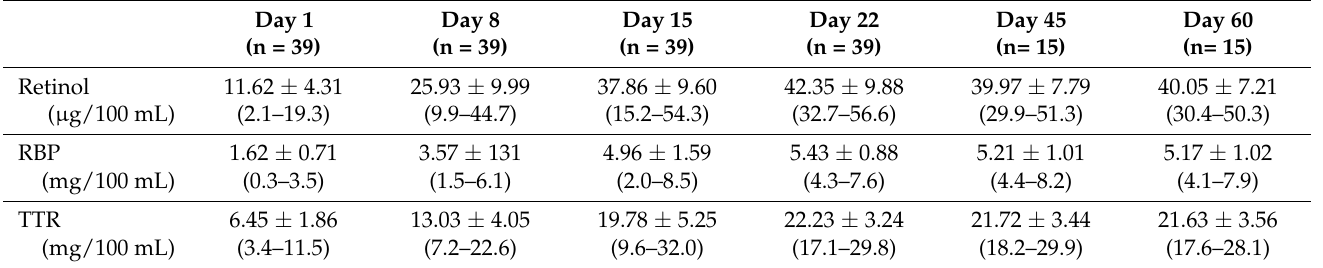
Table 2. Evolutionary patterns of the RCC edifice during the refeeding program of severely protein- depleted